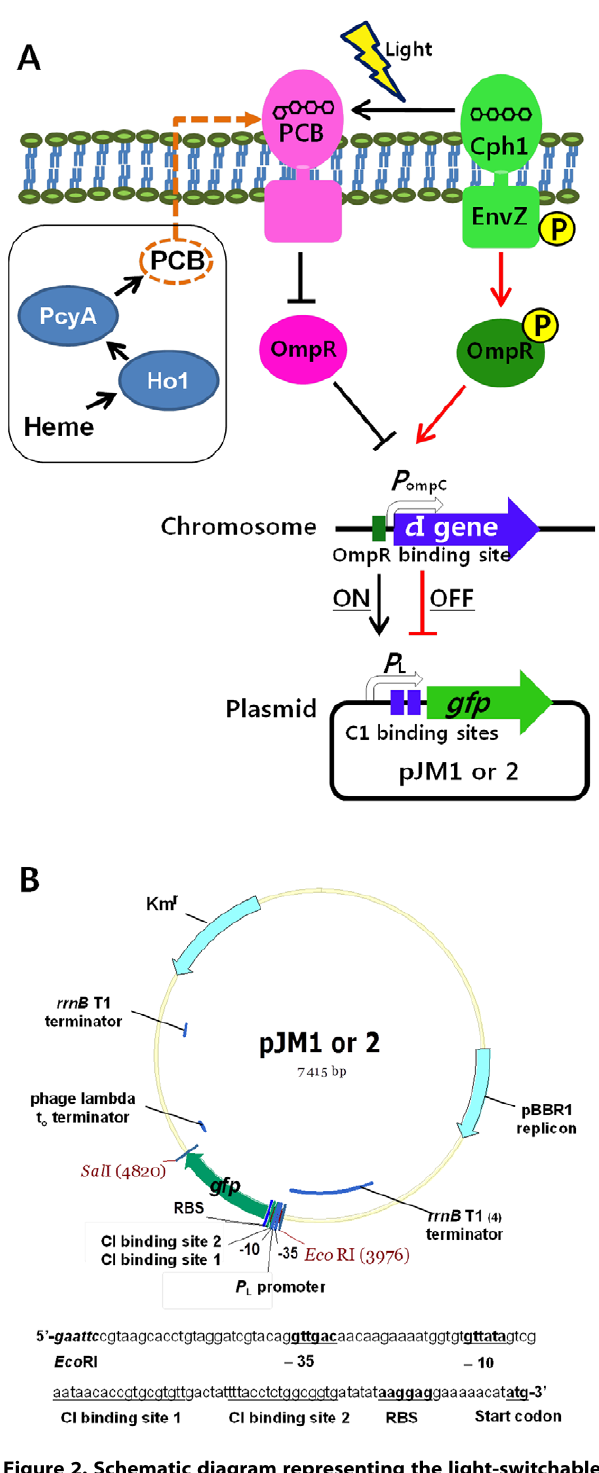
Figure 2. Schematic diagram representing the light-switchable gene expression system. (A) The phycocyanobilin chromophore PCB is synthesized by Ho1 and PcyA enzymes expressed from the pPL-PCB plasmid. The hybrid photoreceptor, Cph8, is a fusion of the photoreceptor Cph1 and the EnvZ histidine kinase expressed from the pCph8 plasmid. The l c I gene containing a rapidly degradable LVA degradation tag is expressed under the control of the P ompC promoter. (B) The reporter plasmids, pJM1 and pJM2, have a gfpuv gene under the control of the P L promoter with 2 CI-binding sites and either a strong or weak RBS. EnvZ, E. coli osmosensor histidine protein kinase/phospha-